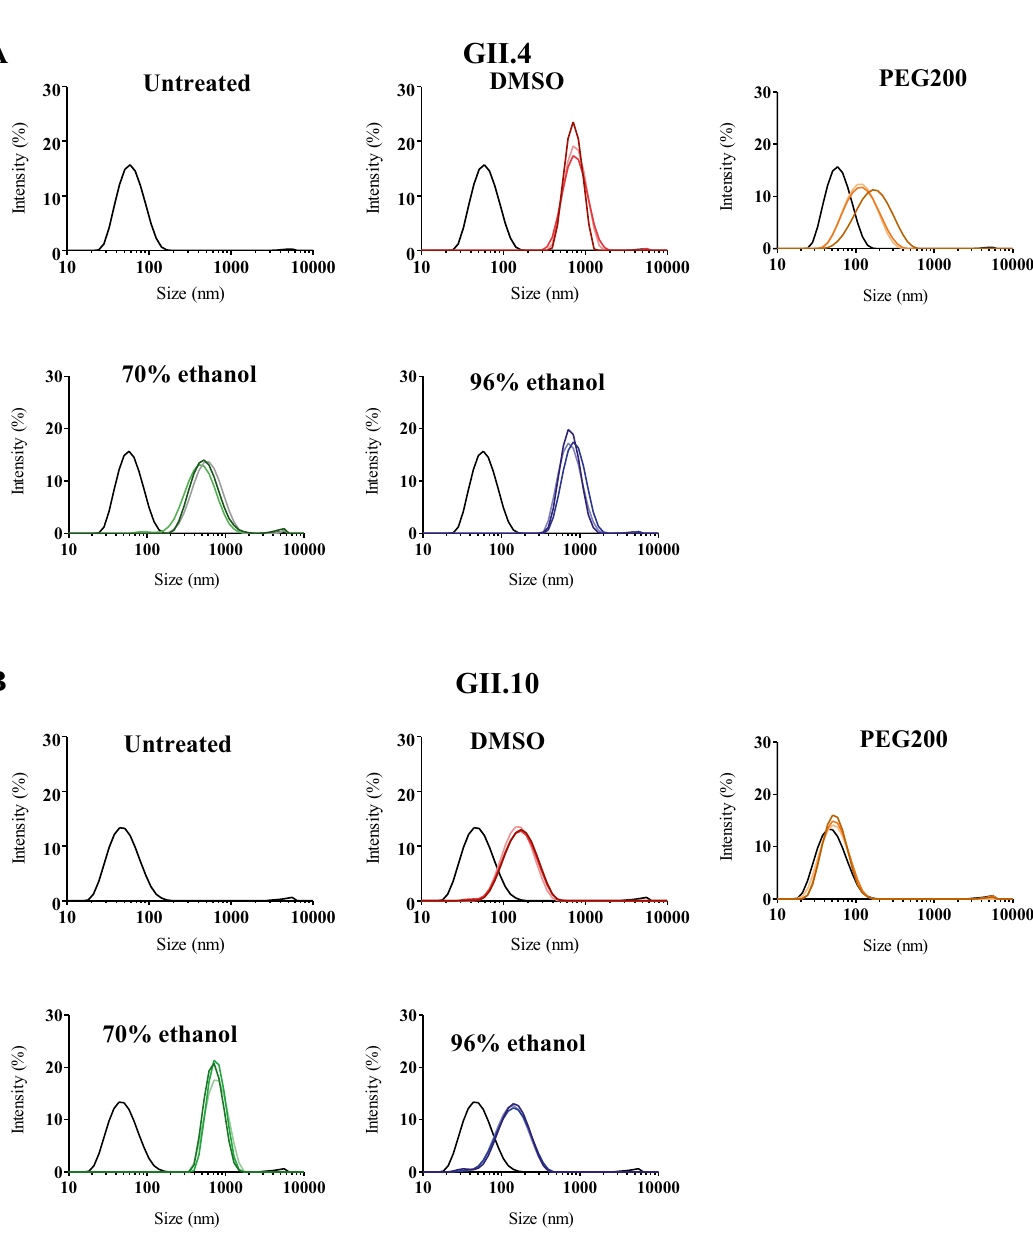
Figure 8. Propolis and DLS measurements of GII.4 and GII.10 VLPs. DLS was used to evaluate the hydrodynamic size of VLPs (final concentration of propolis 12.5%, final concentration of solvents: DMSO 12.5%, PEG200 2.5%, 70%-ethanol 8.75%, and 90%-ethanol 12%) at 10, 60, and 120 min (represented by light, medium and dark colored lines, respectively). Untreated VLPs showed a single peak (black lines). VLPs treated with 100% DMSO propolis, 70% ethanol propolis, and 96% ethanol propolis showed similar peak shifts for ( A ) GII.4 and ( B ) GII.10. The 20% PEG200 propolis treatment also showed a peak shift for GII.4 VLPs, although was less pronounced than with the other propolis samples, while for GII.10 VLPs, the 20% PEG200 propolis showed only a minor peak shift. Each experiment was performed in triplicate and representative measurements were